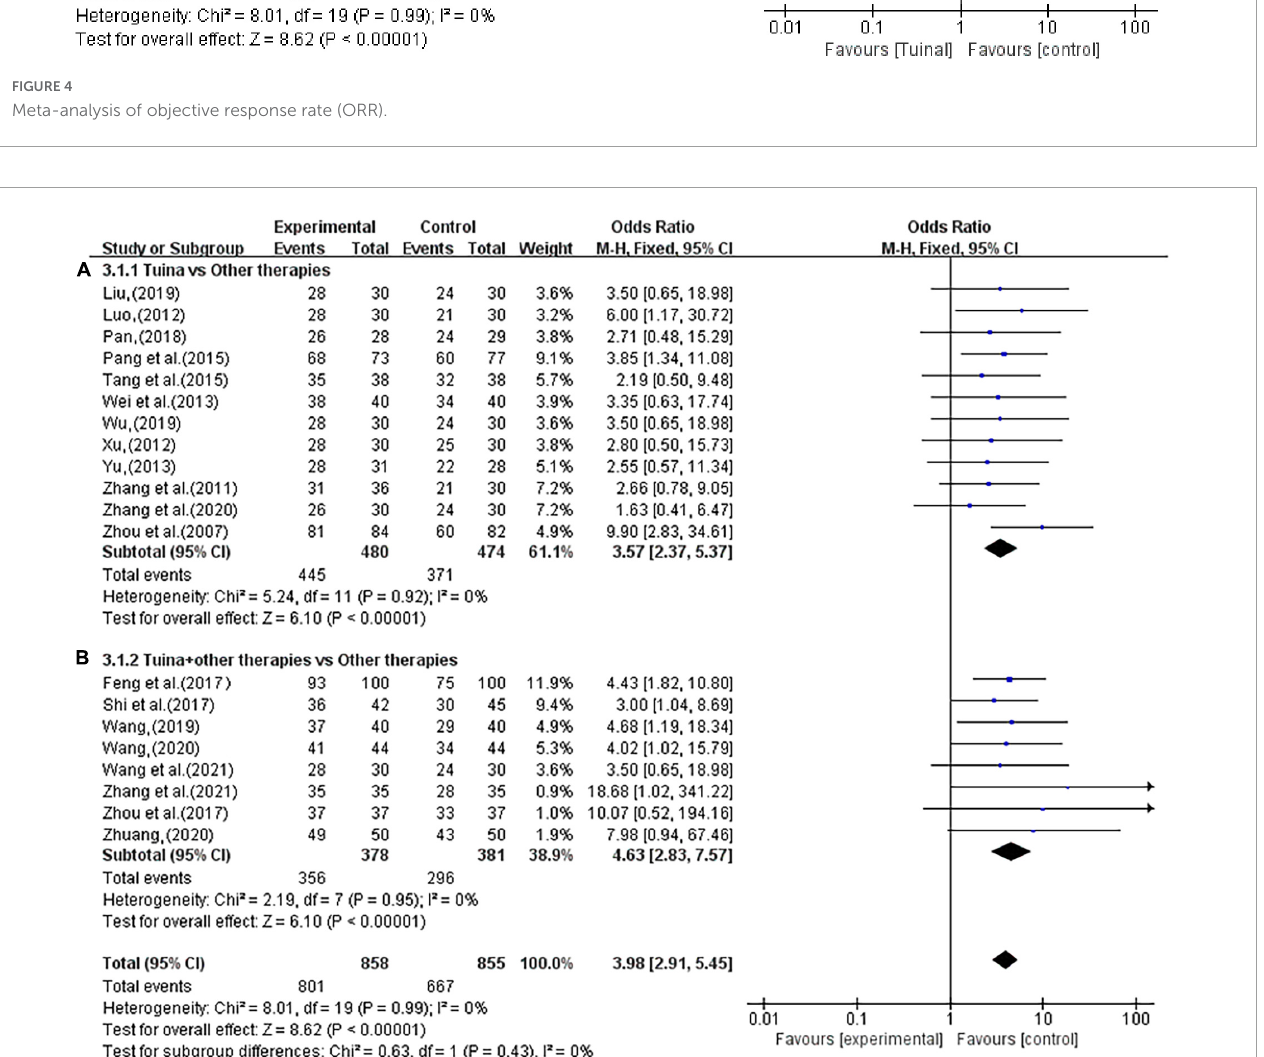
FIGURE5 Forest plot of tuina for objective response rate (ORR). (A) Tuina vs. Other therapies. (B) Tuina + Other therapies vs. Other